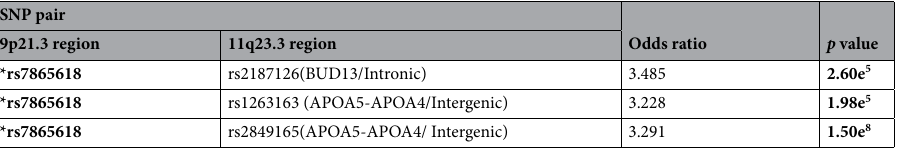
Table 6. Significant SNP-SNP interactions between 9p21.3 and 11q23.3 regions with effects on CAD. *SNP significant for allelic and genotypic association with CAD. Bold indicates the significant risk conferring lone SNP and the p values of